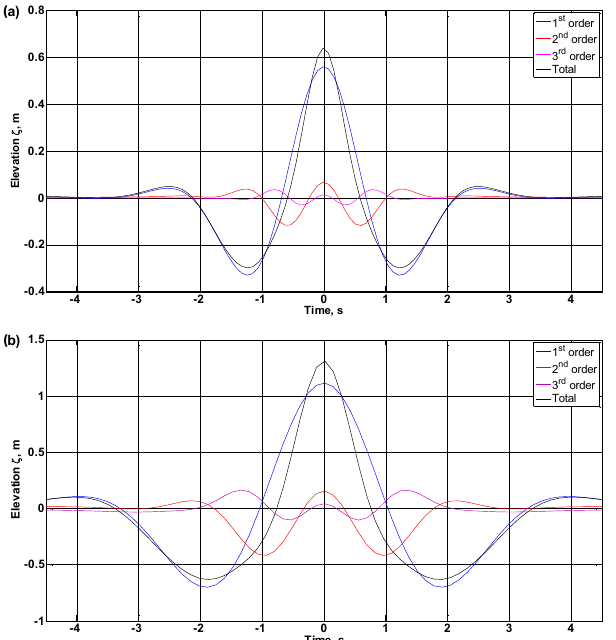
Fig. 1. Variation of the surface elevation with time for ε = 0 . 3: (a) T 0 = 2 . 8s, dominant wave length λ 0 = 12 . 1m; (b) T 0 = 4 . 34s; λ 0 = 25 . 0m.